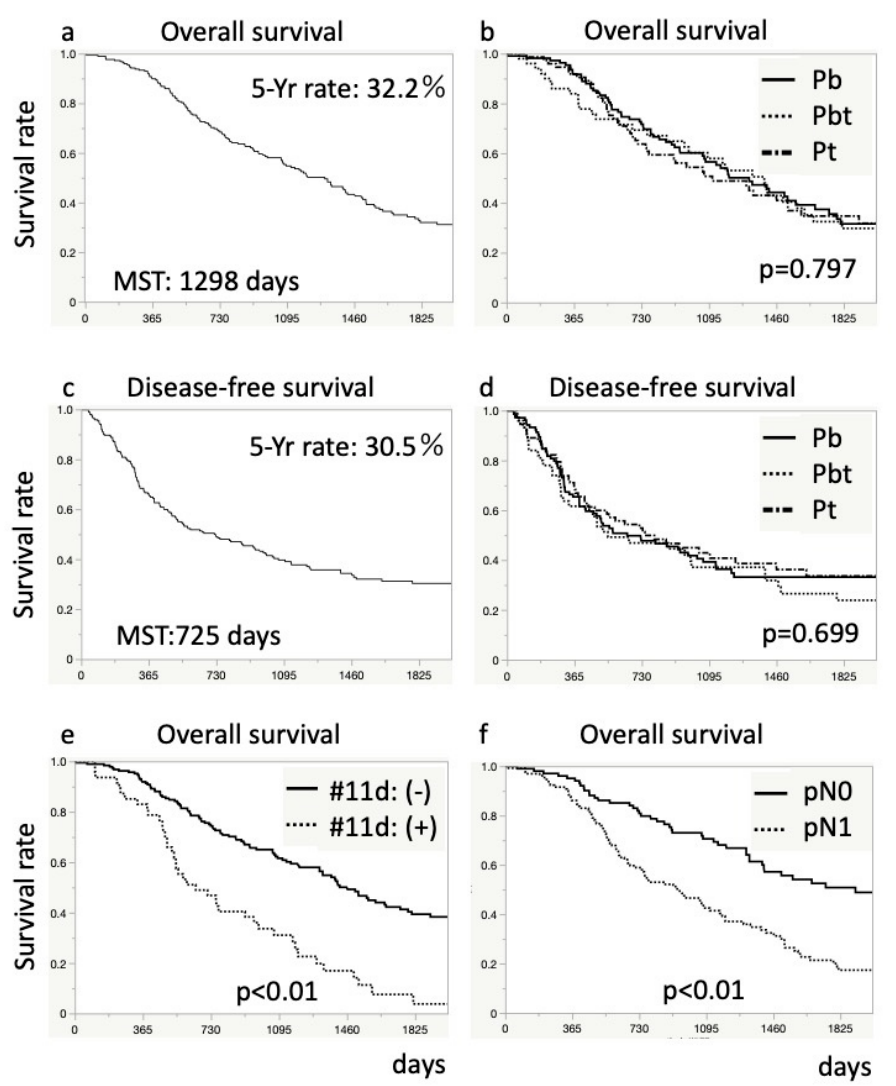
Figure 2. Kaplan–Meier survival curves for patients after distal pancreatectomy. The upper graphs ( a , b ) show overall survival rate, and the middle graphs ( c , d ) show disease-free survival rate. The graphs ( a , c ) present survival rate for all patients. The graphs ( b , d ) show a comparison in survival rates based on the tumor site. The lower graphs ( e , f ) show an overall comparison of survival rates based on lymph node metastasis: ( e ), pathological node category; and ( f ), #11d lymph node metastasis. Differences in survival were analyzed using log-rank tests.